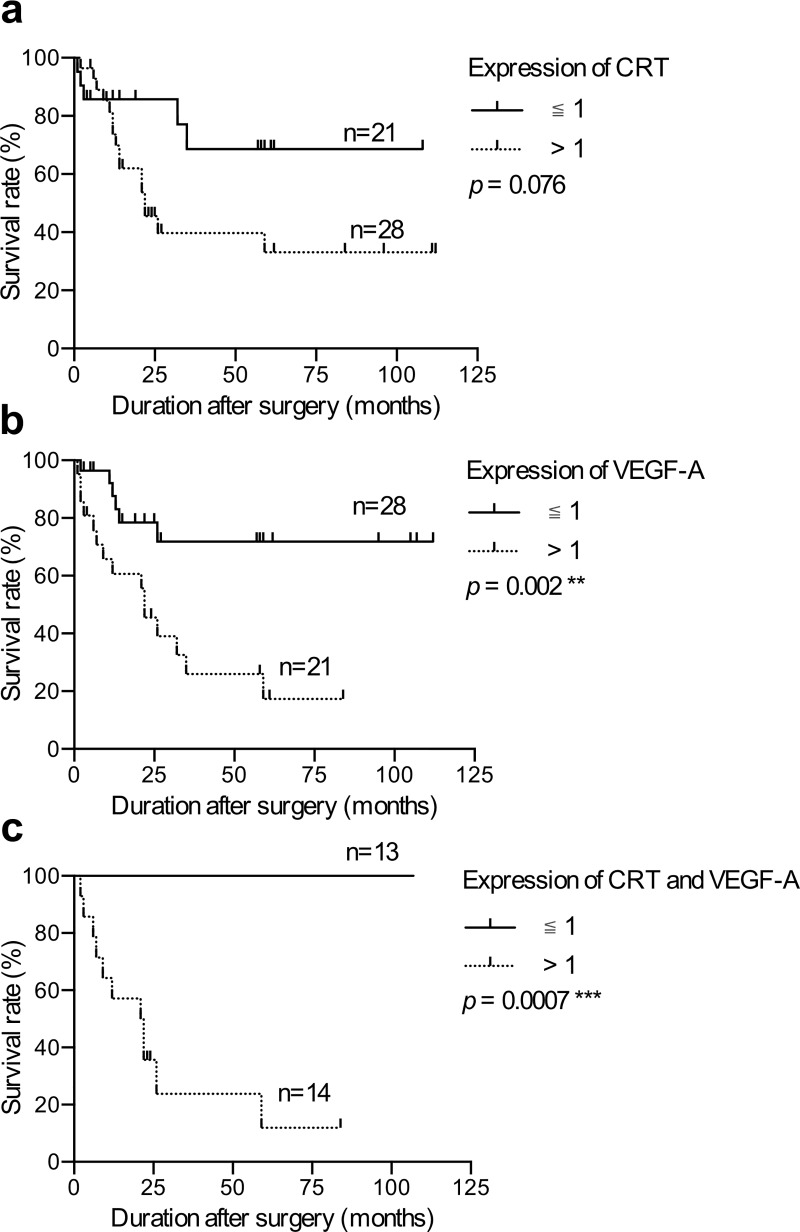
Survival analysis of the patients with gastric cancer.Kaplan-Meier survival analysis according to the expression of CRT and VEGF-A in the gastric cancer patients. The patients were plotted with the expression of CRT and VEGF-A normalized to GAPDH in Western blot and grouped according to the expression level (>1 and ≤1). (a) CRT expression was not significantly associated with survival of the 49 gastric cancer patients. (b) VEGF-A expression was significantly associated with survival of the 49 gastric cancer patients. (c) 14 patients with a high expression of both CRT and VEGF-A had poor survival. P-values were determined using the log-rank test (**P ≤ 0.01, ***P ≤ 0.001).